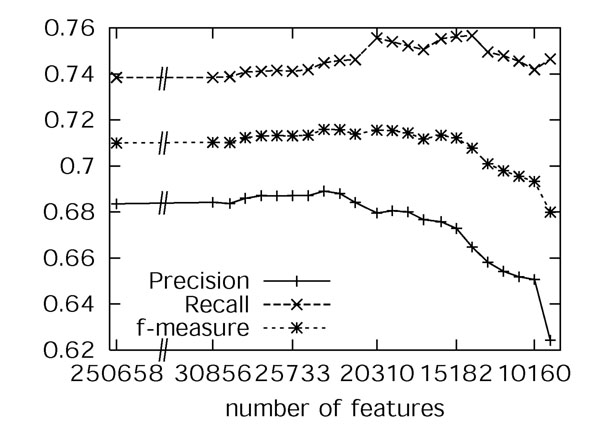
Dependence of the f-measure on the number of features. Performances (precision, recall, f-measure) for different numbers of features. Starting from the full feature set, recursive feature elimination removes the features with the lowest weight vector and we measure the performance after each round.